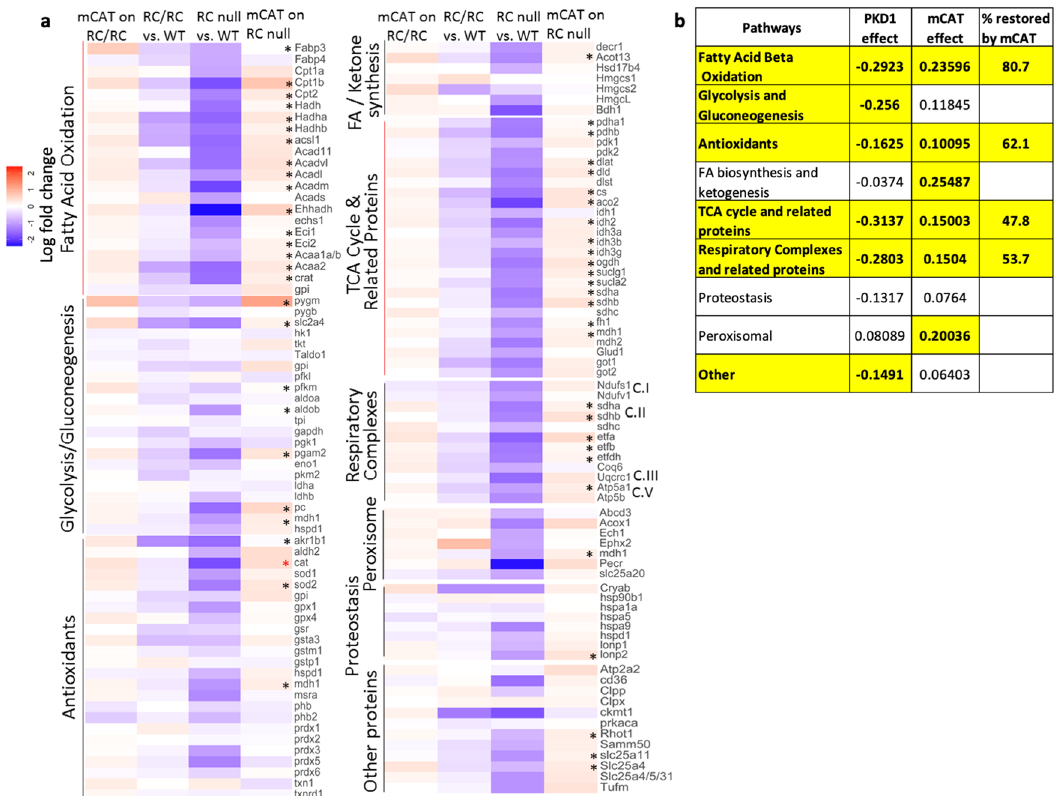
Fig. 5 Targeted proteomics pro fi ling of mitochondrial and metabolic pathways. a Heat maps of relative protein abundance from kidneys isolated from both PKD1 mouse models, RC/RC and RC/null, vs. WT controls in the middle columns and the mCAT treatment effect next to the corresponding group. The middle columns showed that most proteins were in blue, indicating a decreased abundance of several proteins in PKD1 mutation. The mCAT effects were mostly in red, suggesting various degrees of reversal of the PKD1 mutation effect. The asterisks highlight the proteins that show signi fi cant suppression by PKD1, with signi fi cant gene dosage effect and signi fi cant reversal by mCAT. (9 RC/RC, 7RC/RC treated with mCAT, 4 RC/null, 3 RC/null treated with mCAT, and 4 WT mice were used) b Table showing the average magnitude of the effects of PKD1 mutation, mCAT treatment, and the percentage restored by mCAT treatment on proteins involved in mitochondrial and metabolic pathways, as identi fi ed in A. Only highlighted numbers are signi fi